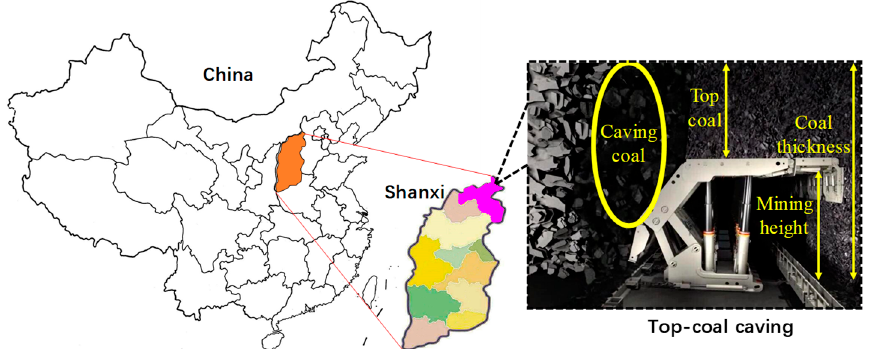
Figure 1. Mining overview of thick coal seam.